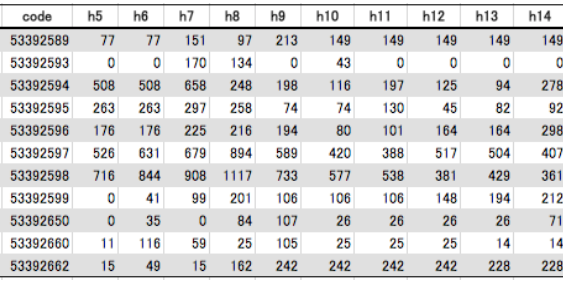
Table 2. Generic text data parsed from the mobile sensing platform. The first column is the Japanese standard mesh code and the first row is time in hourly